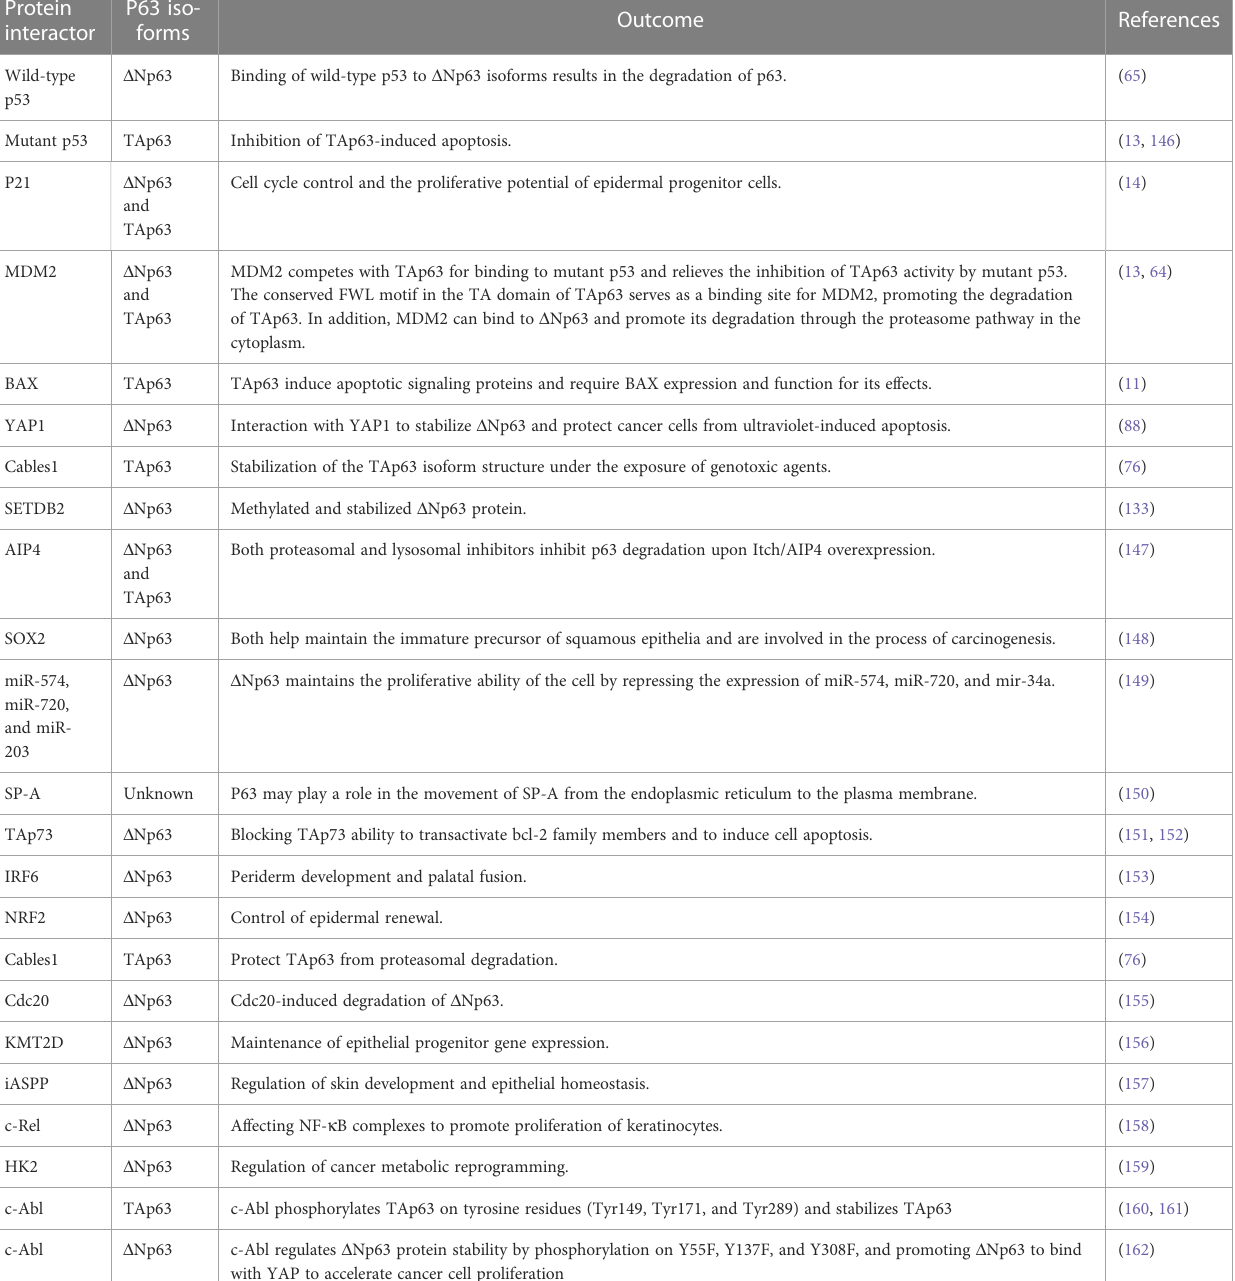
TABLE 1 Interacting partners of p63 isoforms and their effect on p63 function. Protein P63 iso- interactor forms Wild-type